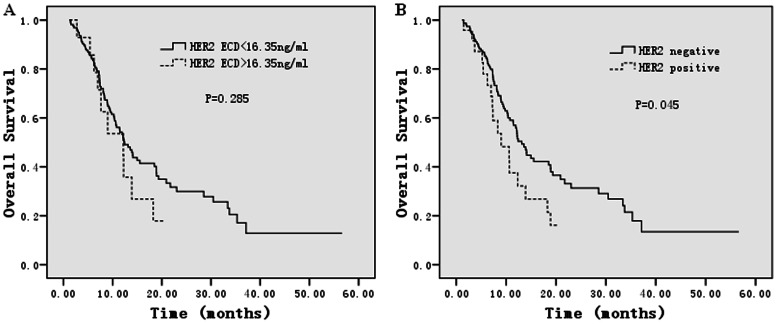
Kaplan–Meier estimates for overall survival according to serum HER 2 ECD levels and tissue HER 2 status.Serum HER 2 ECD levels showed no association with overall survival. Whereas positive tissue HER 2 status was significantly associated with worse overall survival.